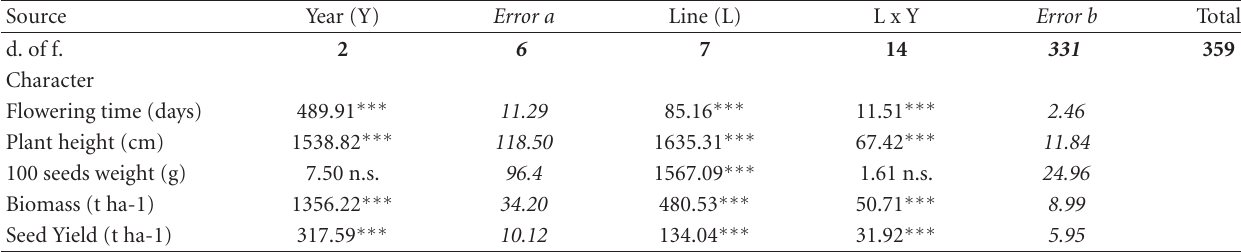
Table 2: Analysis of variance for five characters observed in 8 grass pea lines over three consecutive years